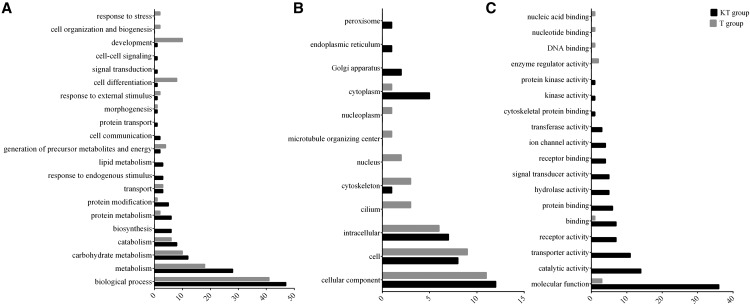
Differences between KT-treated and T-treated fish at 30 min post-injection in the representation of DE genes in the gene ontology (GO) classes for each ontology: A. Biological Process, B. Cellular Component and C. Molecular Function. Enriched GO terms were obtained for upregulated transcripts for each treatment group and mapped to a total of 127 GO slim ancestor terms with CateGOrizer.